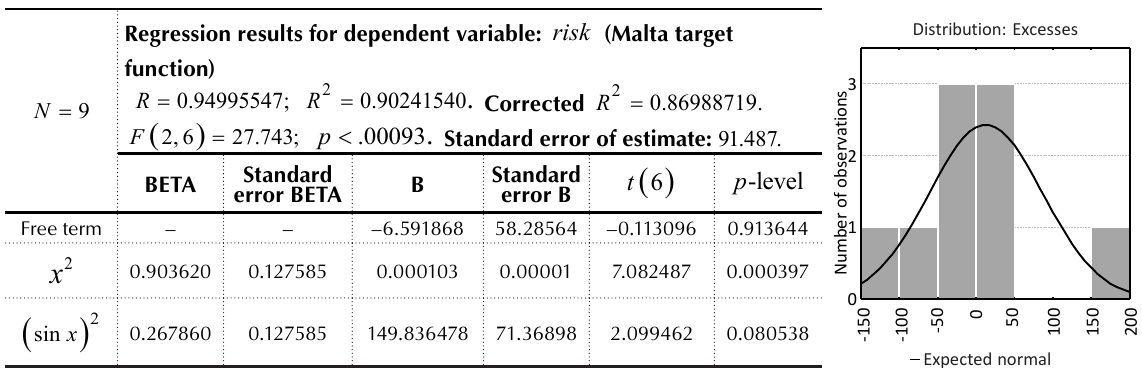
Table 7a. The results of regression for standard deviation of the size of the Investor Compensation Scheme (Malta) ( ) y from its volume ( ) x